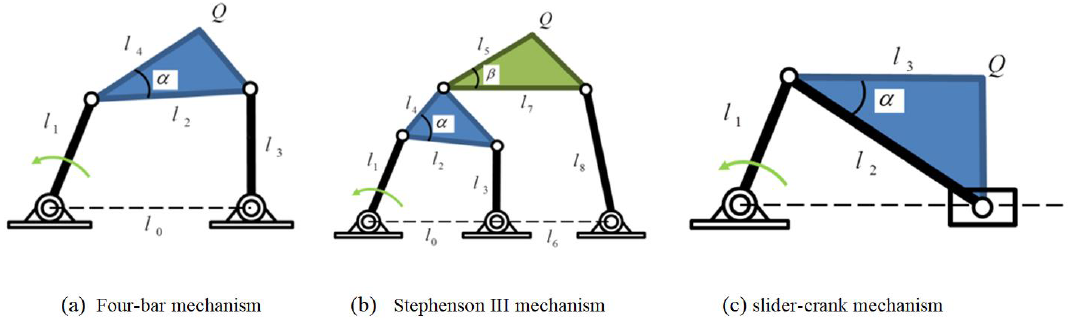
Figure 7. Types of mechanism in library.